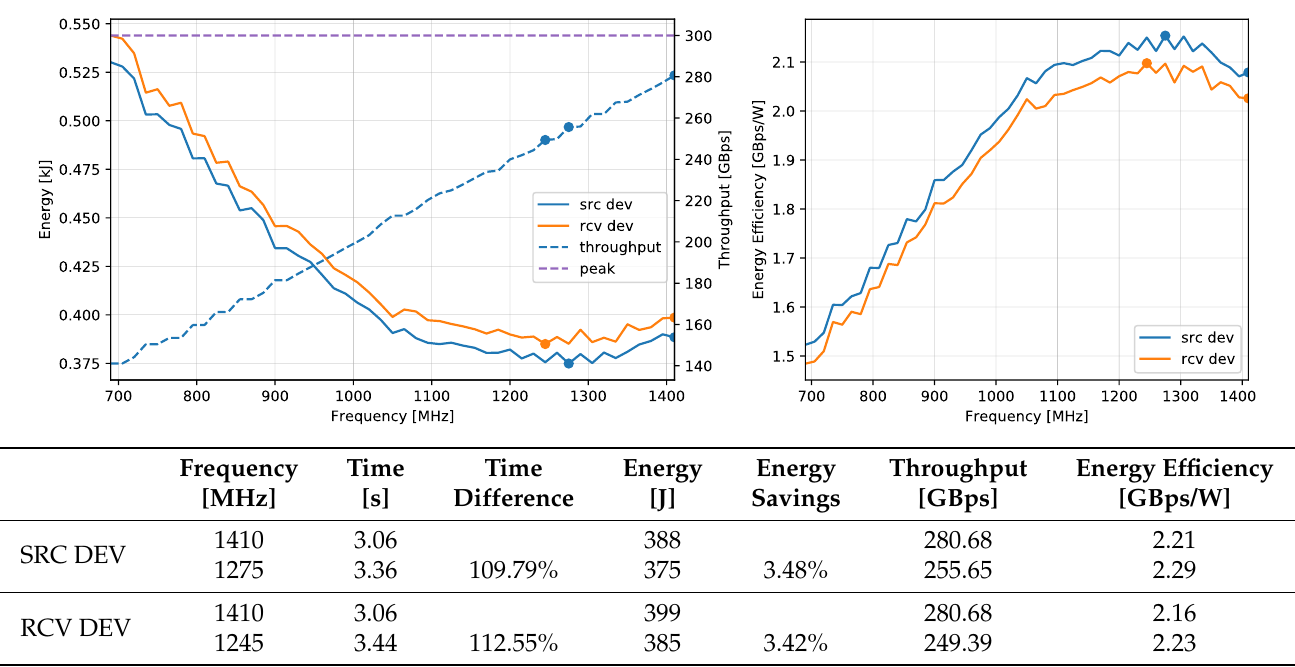
Figure 13. DGX-A100 Frequency scaling of the NVLink P2P transfer benchmark. Plot on the left shows consumed energy and throughput. Plot on the right shows the energy efficiency. The table shows the time difference, energy savings, and energy efficiency of the NVLink transfer at the base and at the optimal frequency. The marker in the plot highlights the two frequencies from the